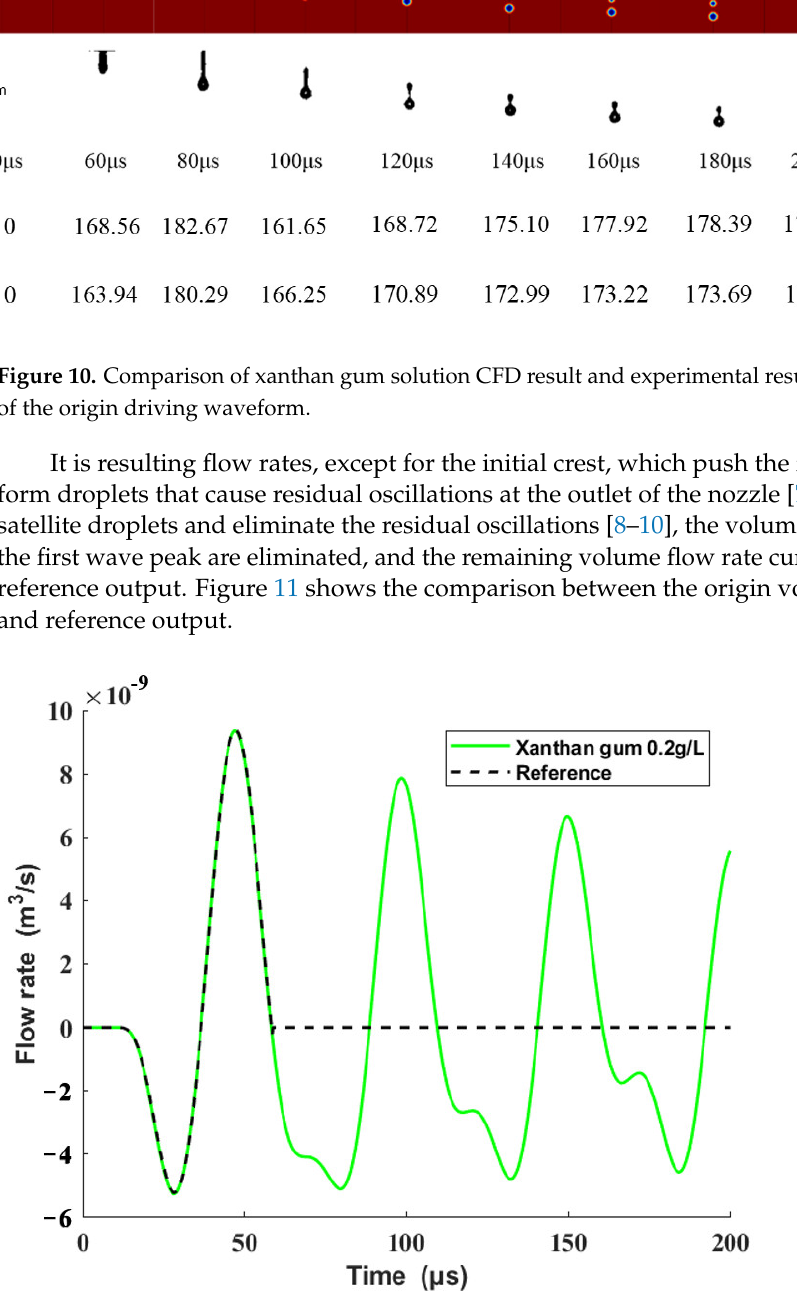
Figure 11. Origin volume flow rates and the reference output.